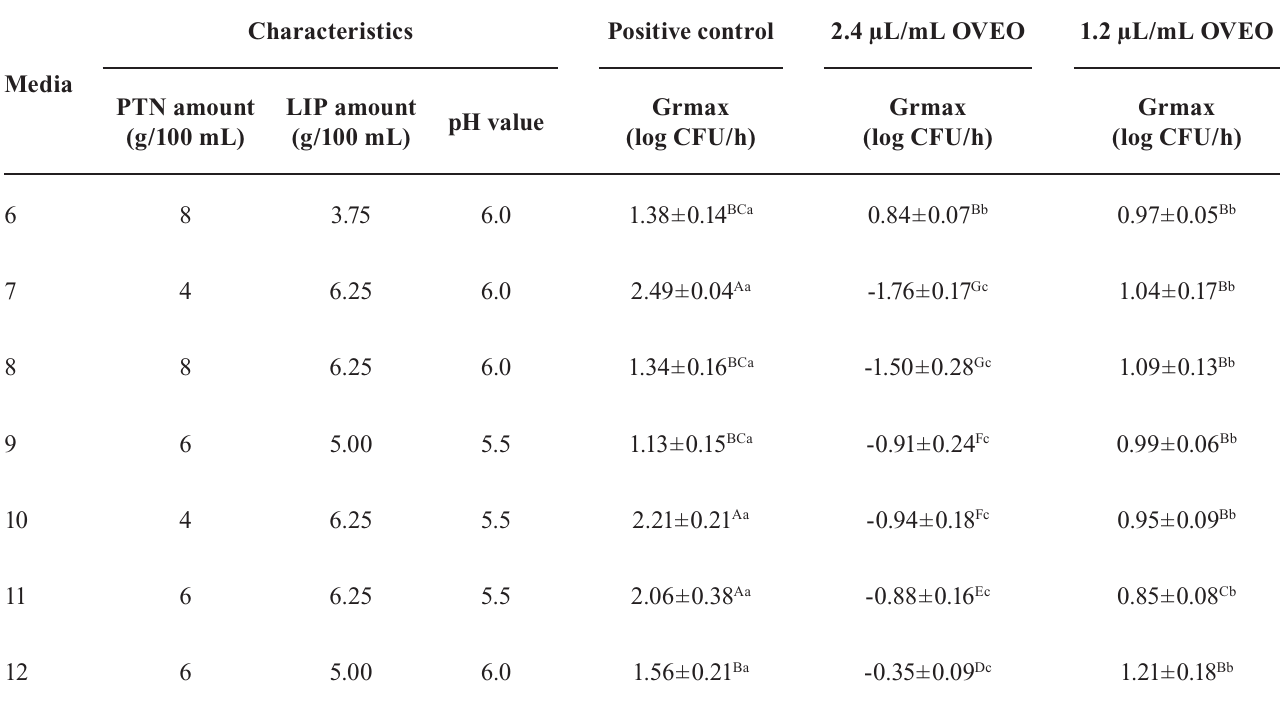
TABLE III - Maximum specific growth rate (Grmax, log CFU/h) estimates for Salmonella Typhimurium PT4 in media with different amounts of proteins, lipids and pH values and 2.4 or 1.2 µL/mL Origanum vulgare L. essential oil (OVEO). Results of Grmax values are expressed as the average ± standard deviation (n=9). The Grmax values were measured by EON-Gen5 software (EON, BioTek, USA) considering the results of absorbance based microtiter plate